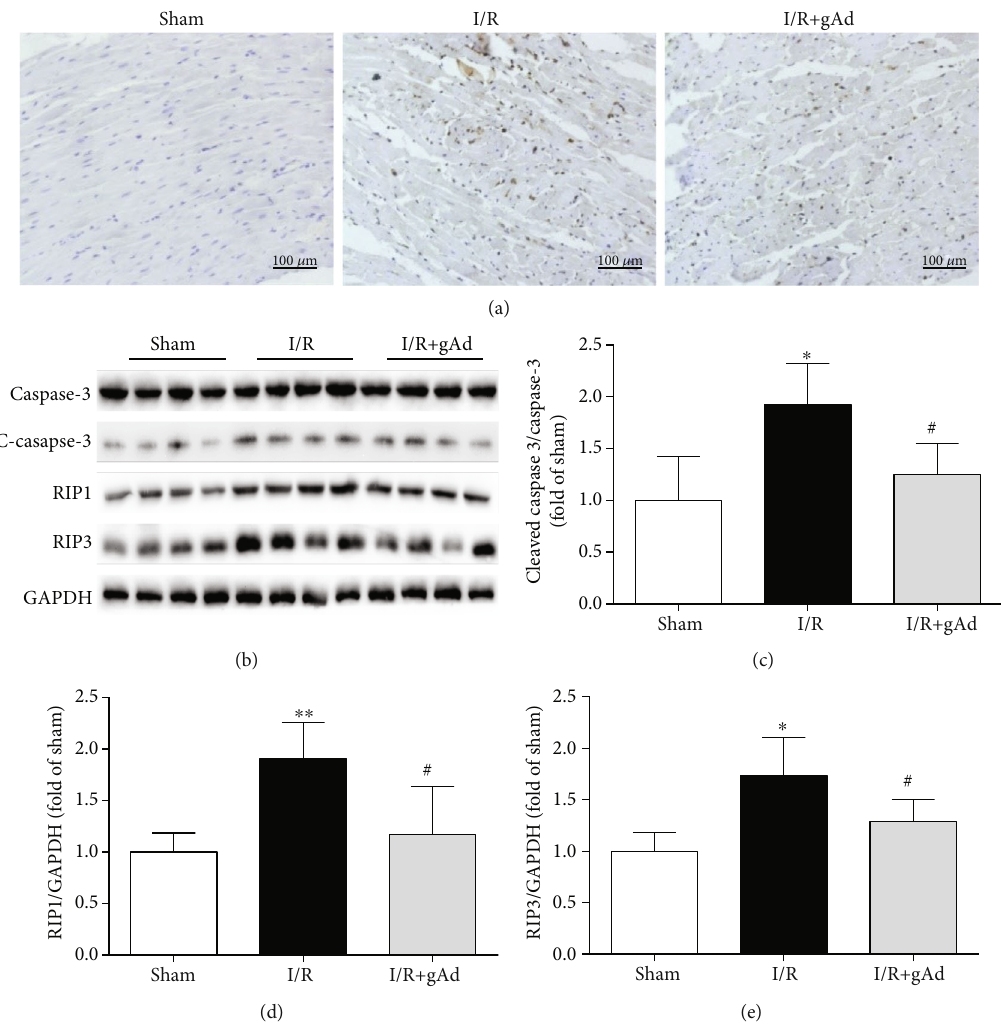
Figure 7: gAd inhibits both apoptosis and necroptosis in the myocardial ischemia/reperfusion rat model. (a) Representative images of the TUNEL staining. (b – e) Western blotting and average data of RIP1, RIP3, and (cleaved) caspase-3 protein abundance in the sham, I/R, and I/R+gAd groups ( n = 6 ). ∗ P < 0 : 05 and ∗∗ P < 0 : 01 vs. the sham group; # P < 0 : 05 vs. the I/R